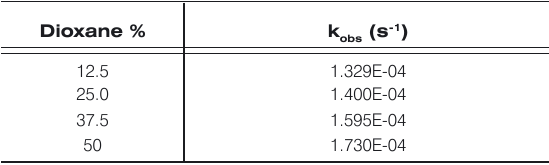
Table 5. Kinetics of the hydrolysis of [Pd(pip)(GlyOMe)] 2+ in dioxane/water solutions of different compositions at 25°C, pH 5.2, and 0.1 M ionic